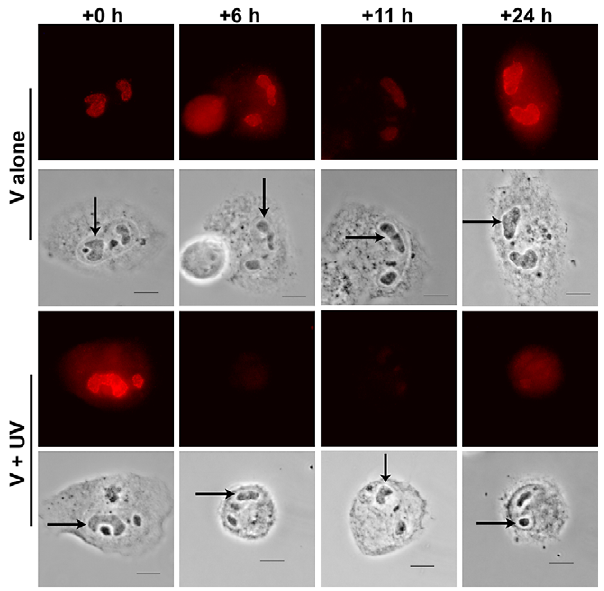
Figure 4. BrdU multipulse/chase experiments showed viral DNA replication was arrested after irradiation. Two plates of HFFs on glass coverslips were infected at an MOI of 5. One plate was irradiated at 75 J/m 2 at 48 hpi and the other was left unirradiated Individual coverslips were pulse labeled with BrdU one h prior to harvesting (at 2 1,5,10 and 23 hpi, respectively). Coverslips were harvested at 0, 6, 11 and 24 hp irradiation. Cells were fixed and stained for BrdU incorporation (red) into viral RCs as described previously [68]. All images were captured using the same exposure time for direct comparison. Phase images of cells are pictured to show location of viral RCs within the nucleus (an example within each image is denoted by an